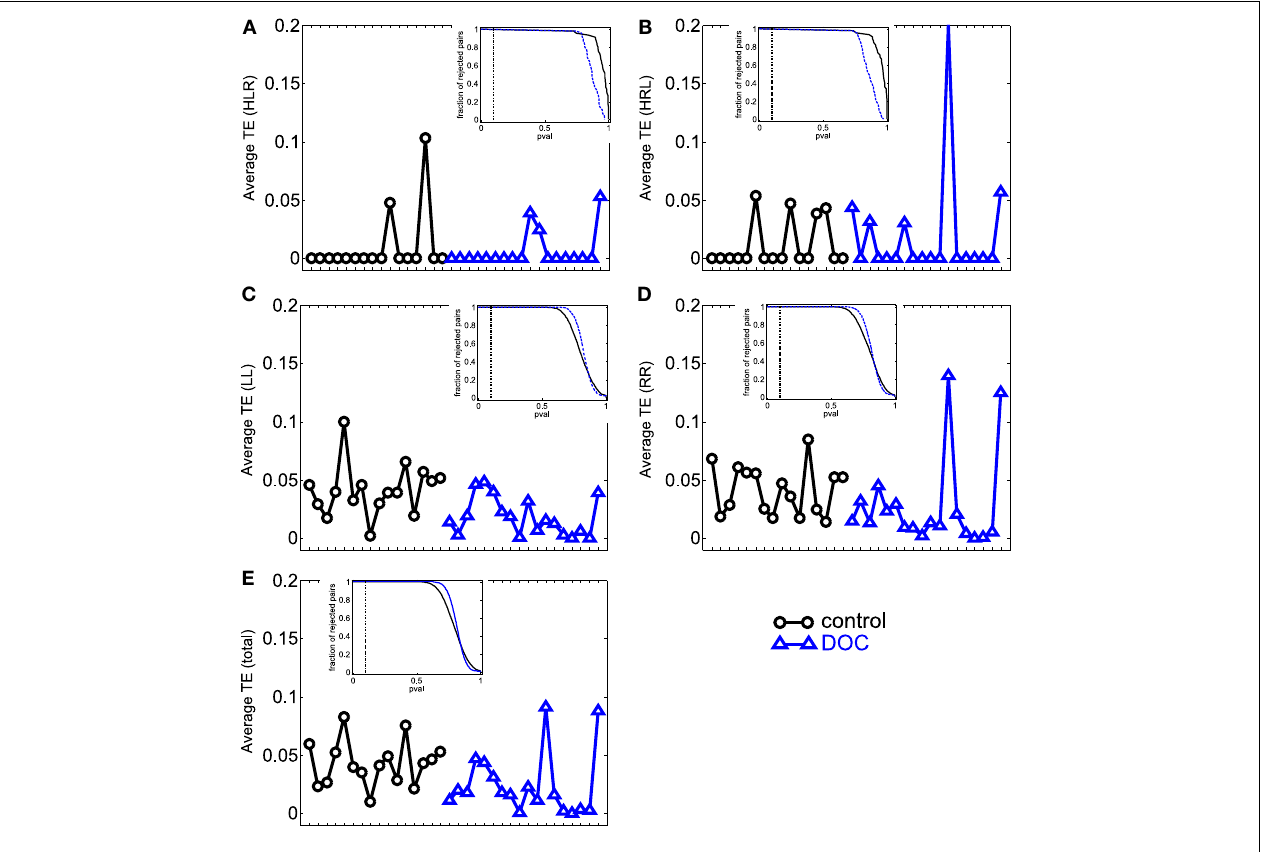
FIGURE 3 | Average TE values per subject. (A) HLR (homologue left-right inter-hemispheric areas); (B) HRL (homologue right-left inter-hemispheric areas); (C) LL (left intra-hemispheric); (D) RR (right intra-hemispheric); (E)